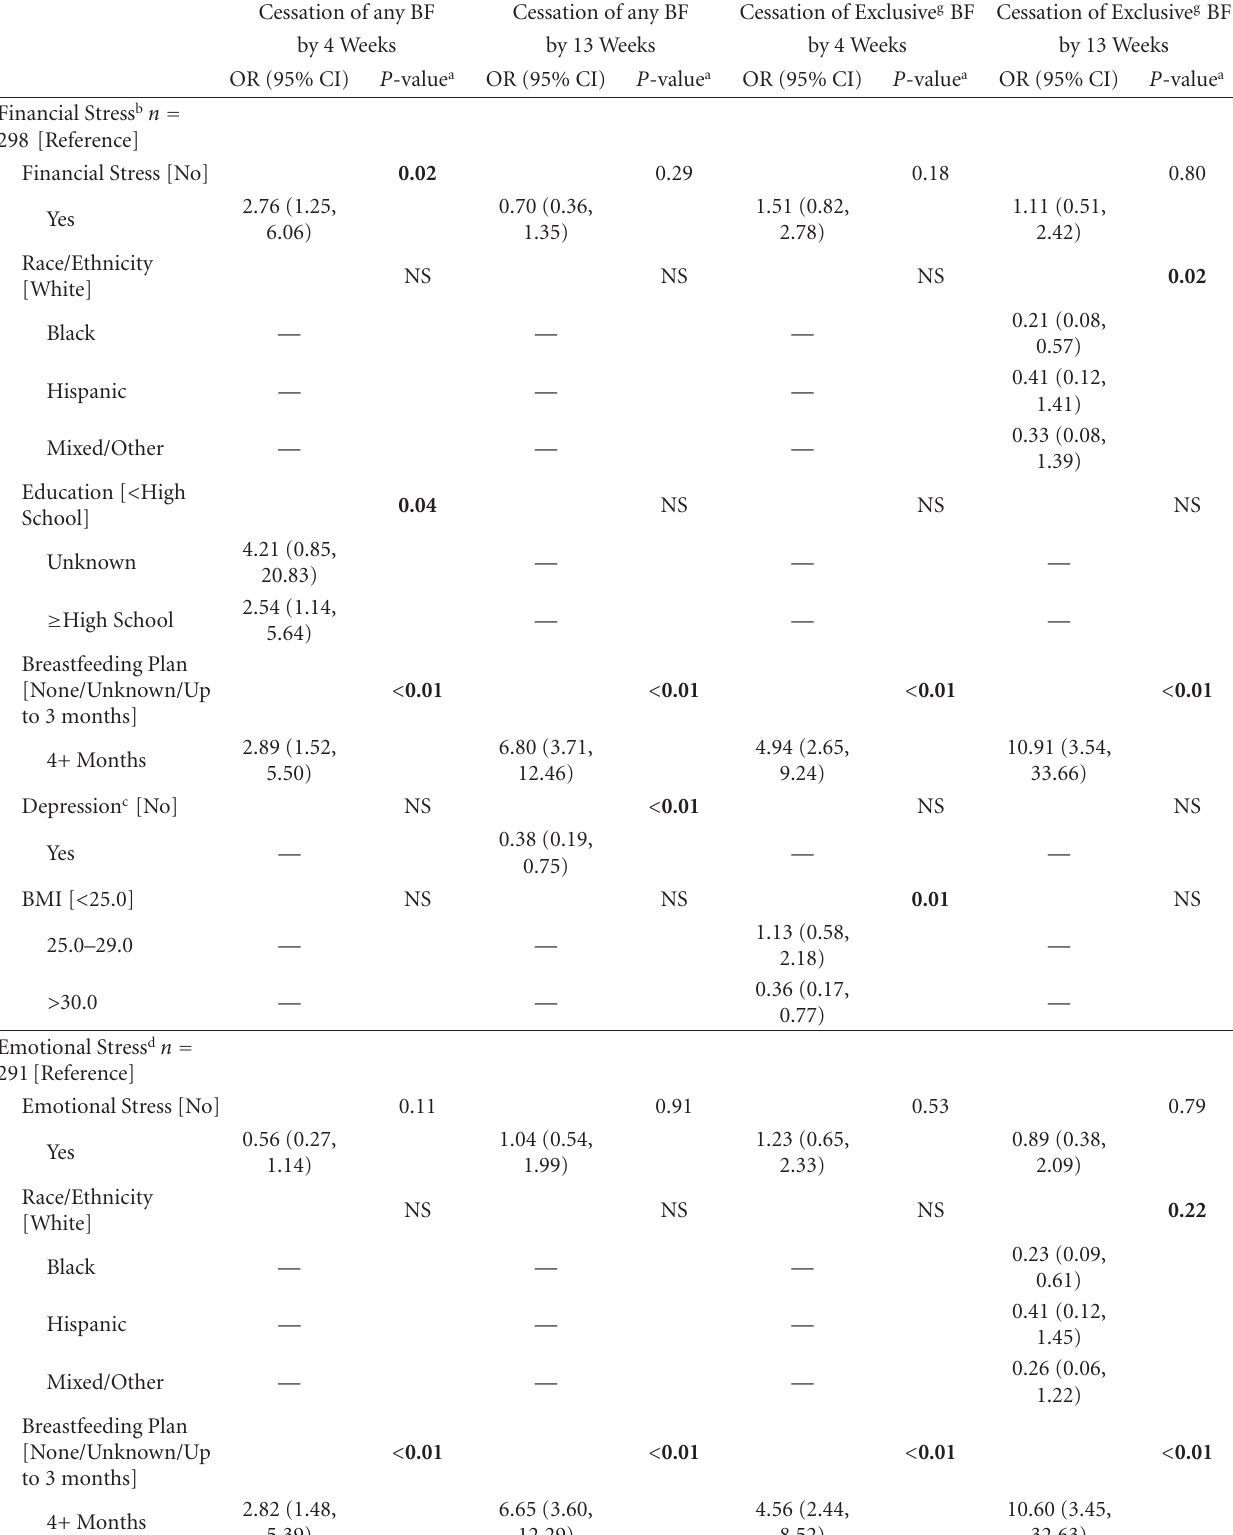
Table 4: Stress logistic regression for breastfeeding duration and exclusivity outcomes modeling for breastfeeding cessation. Cessation of any